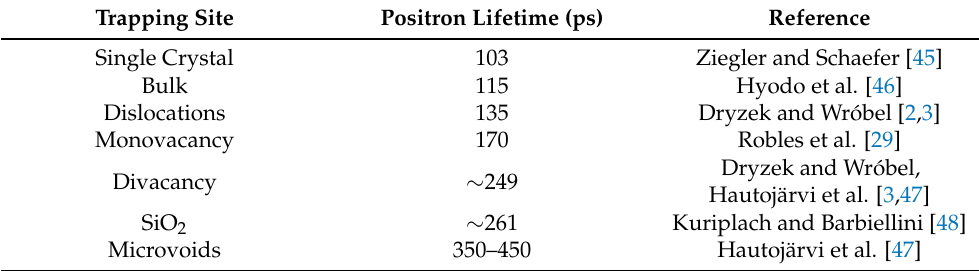
Table 6. Positron lifetimes for various trapping sites in molybdenum.